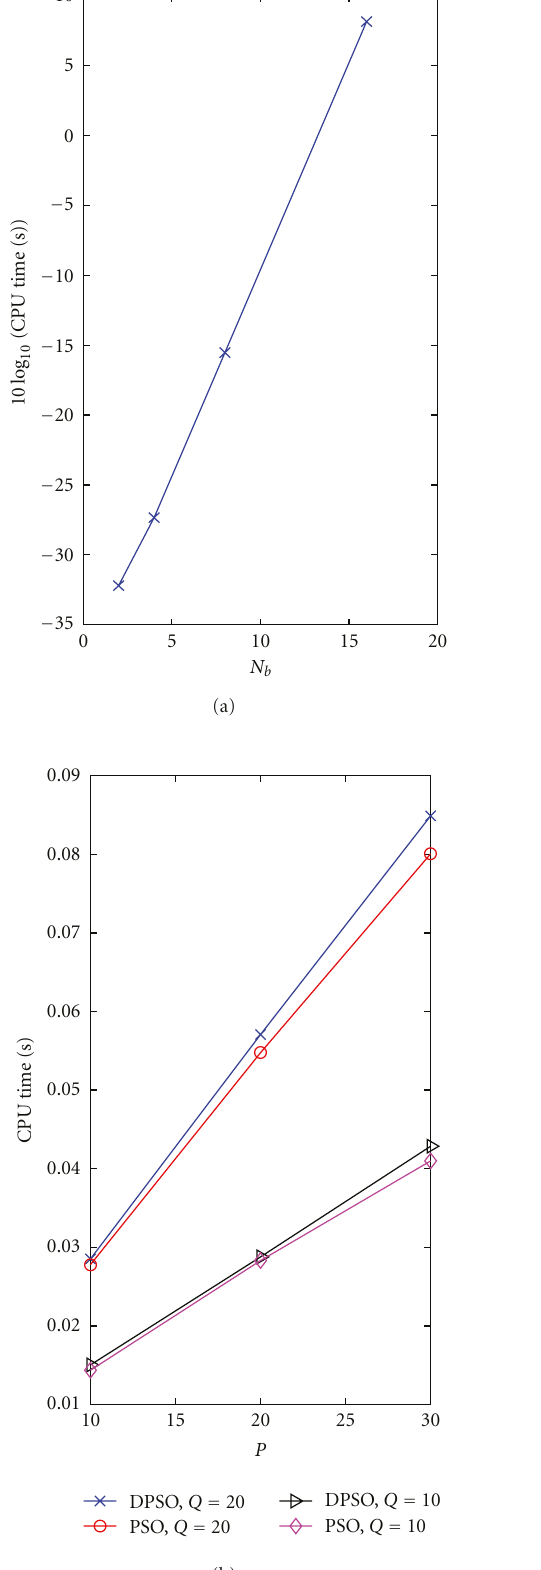
Figure 5: CPU time of the algorithms (a) Optimal PTS-AIC (b) DPSO and PSO, Q = 10,20.